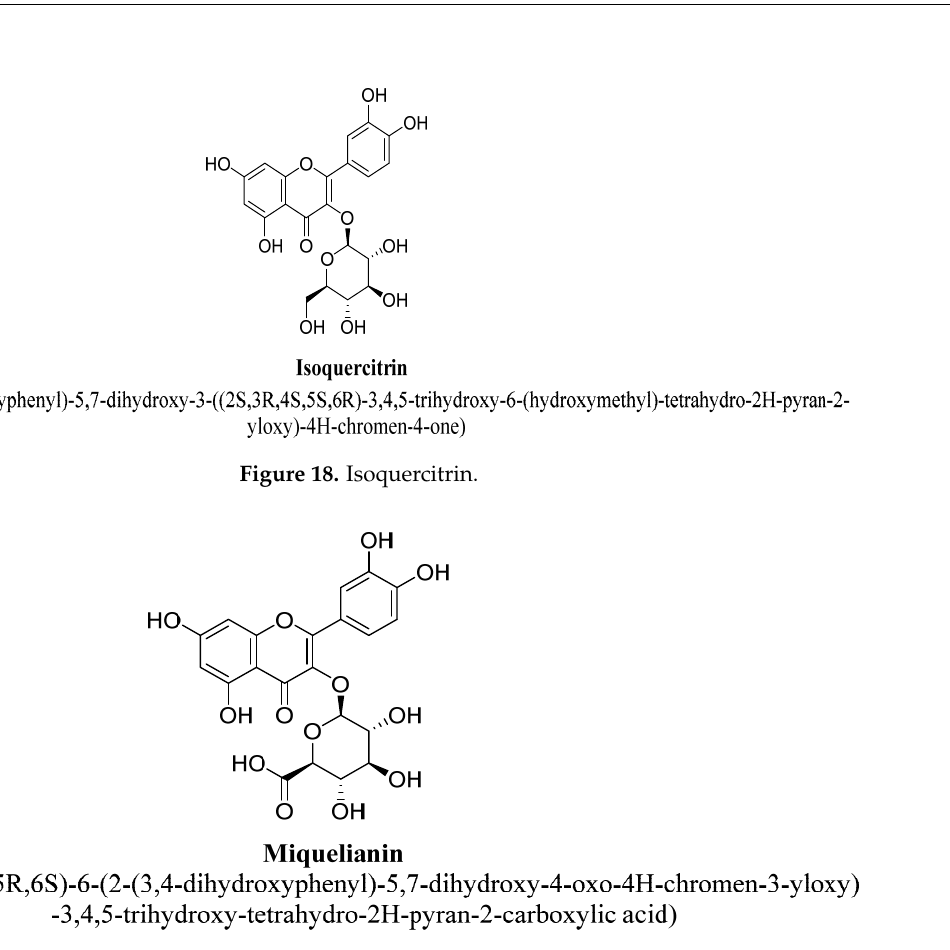
Figure 19. Miquelianin.